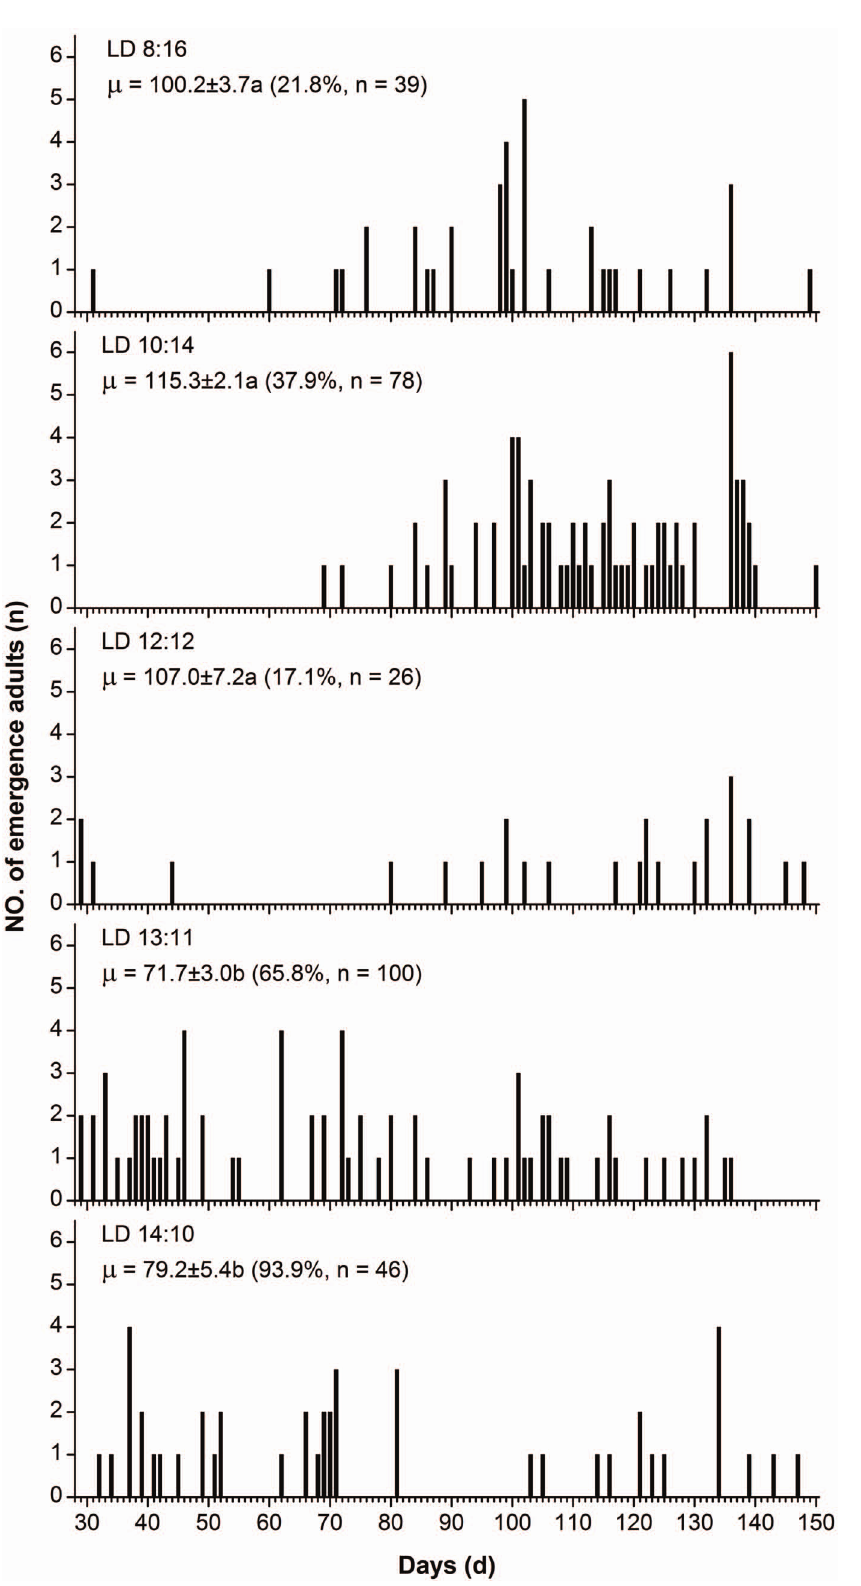
Figure 4. Duration of pupal diapause in H.cunea under LD 15:9 at 28 u C, after diapause was induced by different photoperiods at 28 u C. Values followed by different letters are significantly different by the Kruskal-Wallis test and Bonferroni multiple comparisons ( x 2 =85.29, d.f.=4, P =0.000 , 0.01). Values in parentheses are numbers of adults emerged from diapausing pupae and survival rate after diapause.